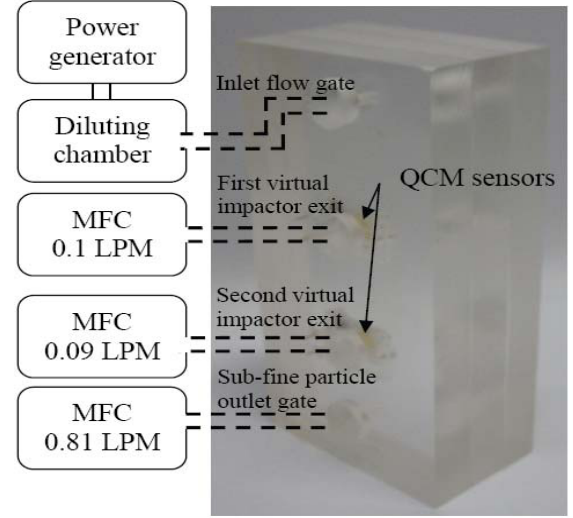
Figure 11. The QCM sensors are put into the virtual impactors for testing the integrated system. The interconnections between the virtual impactors and the flow controllers are illustrated by dashed